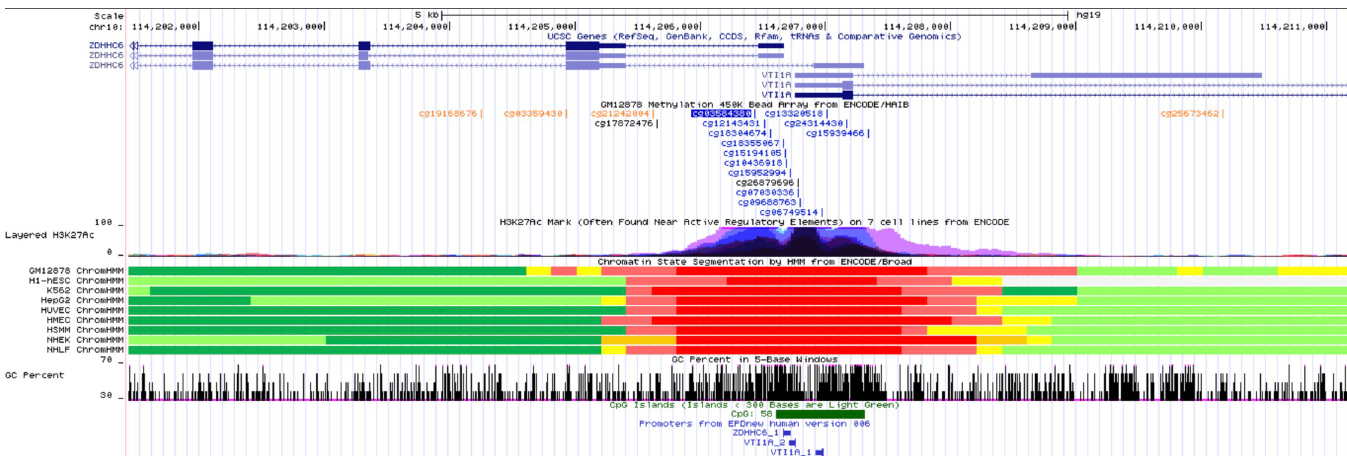
Fig 2. ENCODE annotation of cg03584380 on intron 1 of ZDHHC6 . The annotation for cg03584380 includes CpG islands, cell line chromatin state (ChromHMM), H3K27Ac marks, and cell line methylation at CpG sites on the Methyl450 Bead Arrays from ENCODE/Hudson Alpha Institute for Biotechnology (ENCODE/HAIB; bright blue, purple, and orange CpGs correspond to unmethylation, partially methylated, and methylated states, respectively).